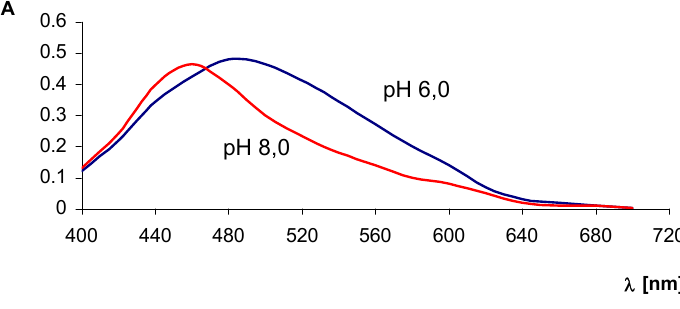
FIGURE 1 . Spectra of neutral red after immobilization on a triacetylcellulose membrane.